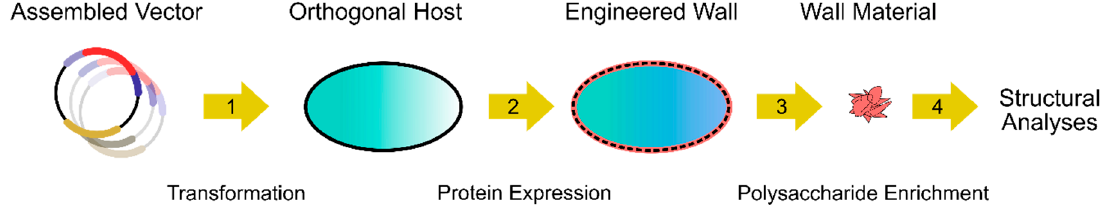
Figure 1. Strategy to study plant cell wall biosynthesis using synthetic biology. Plant genes of interest are assembled in one or more vectors and transformed (Step 1) into orthogonal hosts. Following recombinant protein expression (Step 2), the extracellular matrix of the engineered cells is extracted to assess if the expected polymer has been synthesized (Step 3). Lessons from structural analyses of enriched polysaccharides (Step 4) inform the next round of engineering.